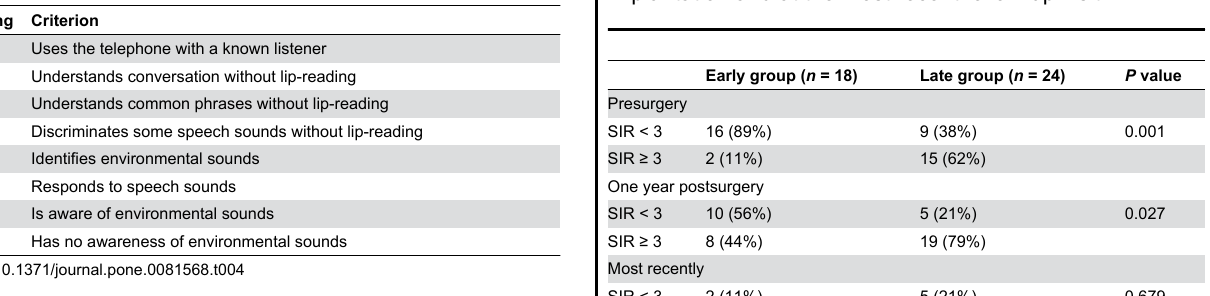
Table 6. Number of patients with a SIR score below 3 for evaluations made before implantation, one year after implantation and at the most recent follow-up